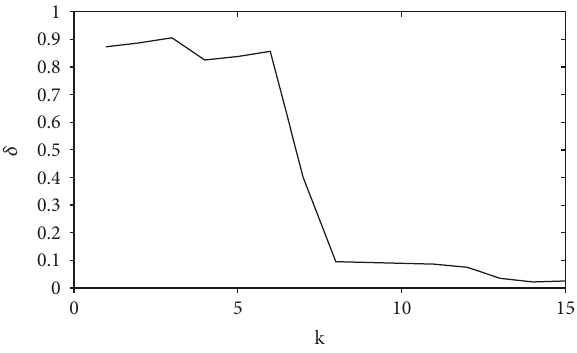
Figure 2: The parameter estimation errors versus δ .